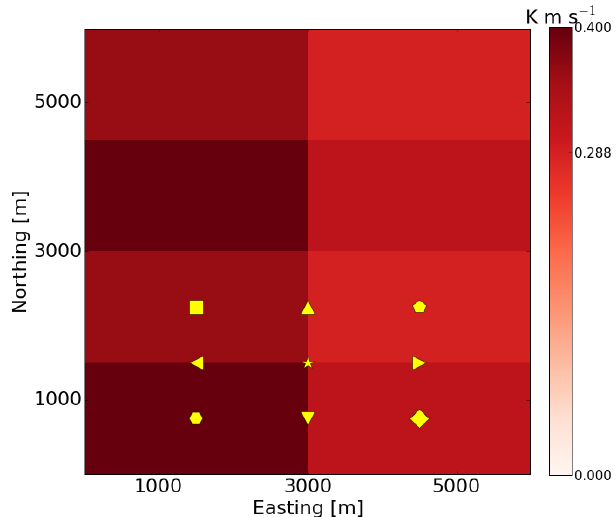
Figure 2. Fixed location of the virtual towers for the kilometer scale heterogeneity. The surface heat flux pattern of this example corre- sponds to L x = 3000m, L y = 1500m. Please note that all the con- trol volumes have the same shape of 5 × 5 × 5 grid points, the sym- bols are only to distinguish the different types of towers. For the hectometer scale heterogeneity, the towers are located at the similar positions in or in between the patches, only the patches are smaller. The towers fall into two classes: those located at the center of the patches and those located at the